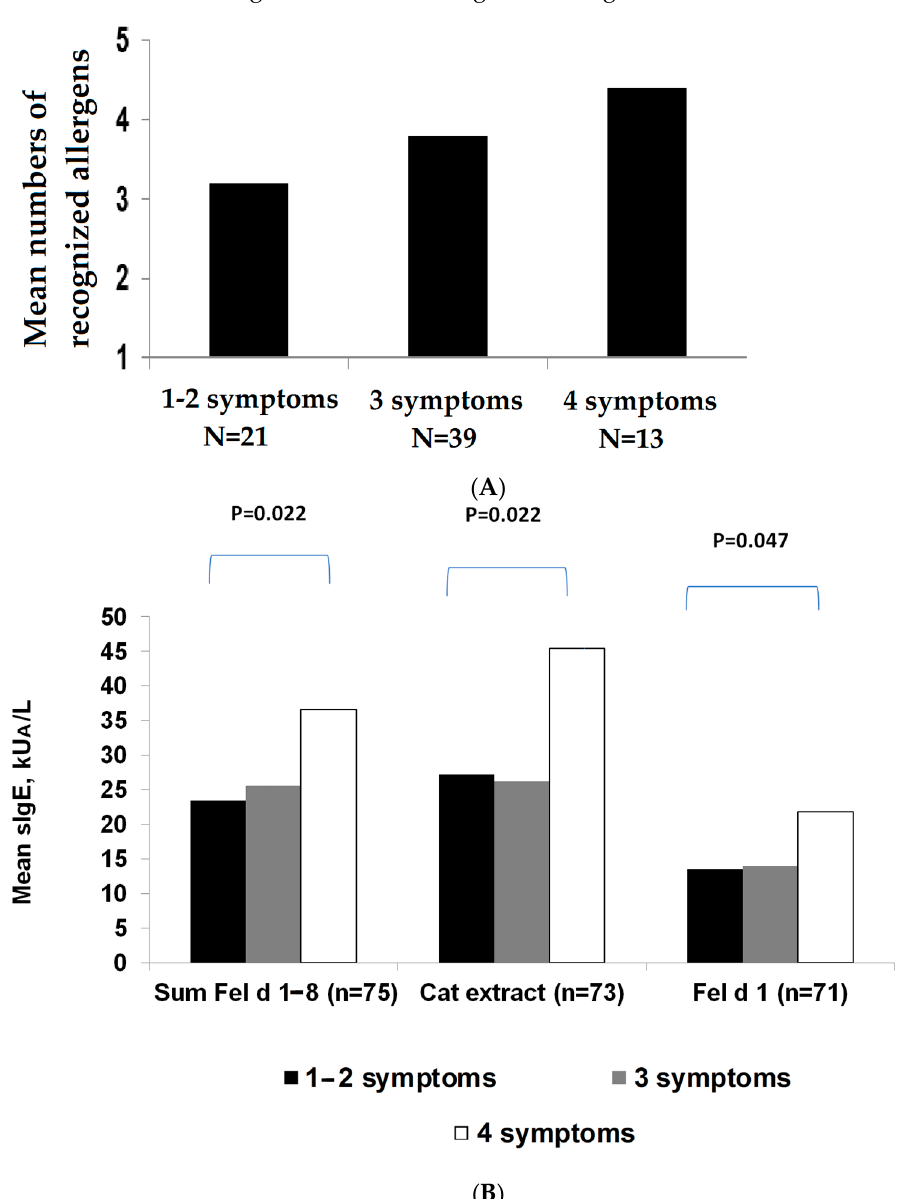
Figure 5. ( A ) Mean numbers of recognized allergens in patients suffering from 1–2, 3, or 4 cat-related allergic symptoms (asthma, rhinitis, conjunctivitis, and dermatitis); ( B ) mean levels of IgE ( y -axis) specific to the sum of allergen molecules, the cat extract, and Fel d 1 ( x -axis) in patients suffering from 1–2, 3, or 4 cat-related allergic symptoms ( x -axis). Significant differences were calculated using the Mann–Whitney U test and are indicated for p ≤ 0.05 between the groups.